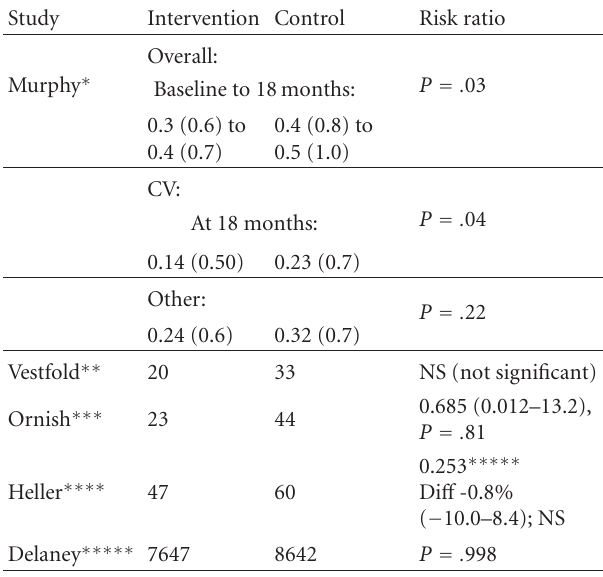
Table 3: Impact of interventions on hospital admissions.